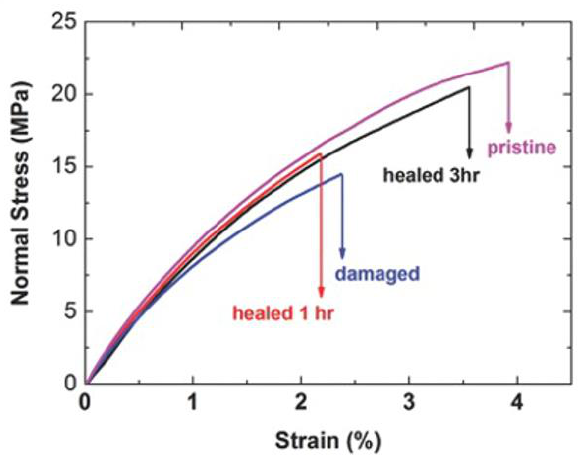
Figure 26. Self-healing effectiveness of thermally cured S-MMA-POSS samples evaluated with stress – strain tests. Copyright (2017) Wiley. Used with permission from (Lin, H.-K.; Liu, Y.-L., Reac- tive Hybrid of Polyhedral Oligomeric Silsesquioxane (POSS) and Sulfur as a Building Block for Self- Healing Materials, Macromol. Rapid Commun . 2017, 38 , 1700051; WILEY-VCH Verlag GmbH & Co. KGaA, Weinheim) [85].